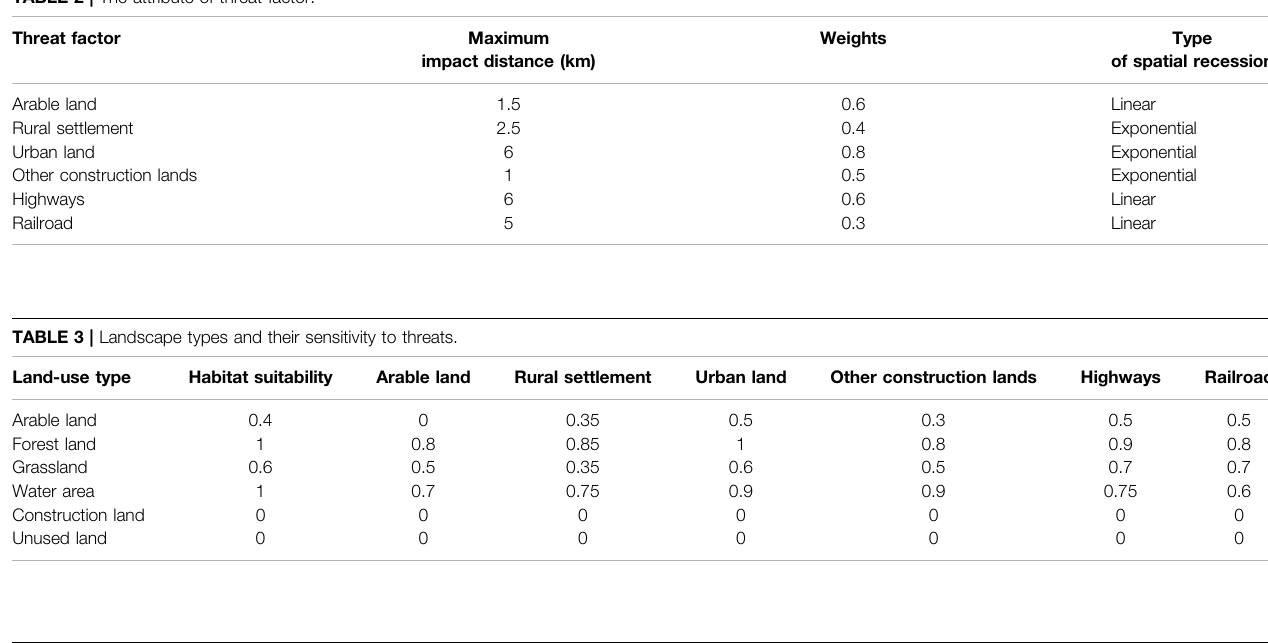
TABLE 2 | The attribute of threat factor.